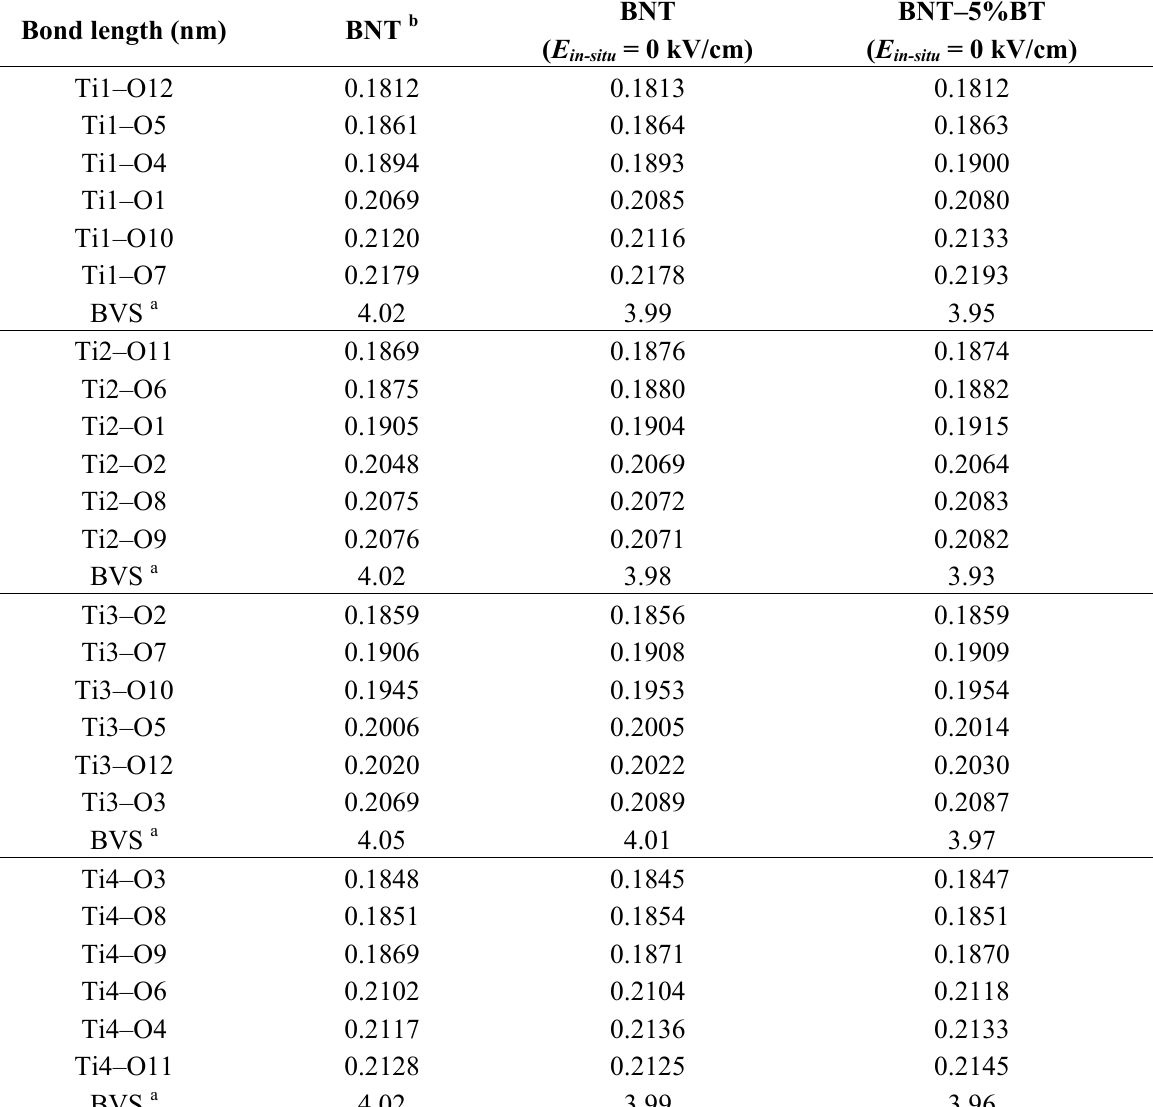
= 0 kV/cm in the Pc cell. in-situ